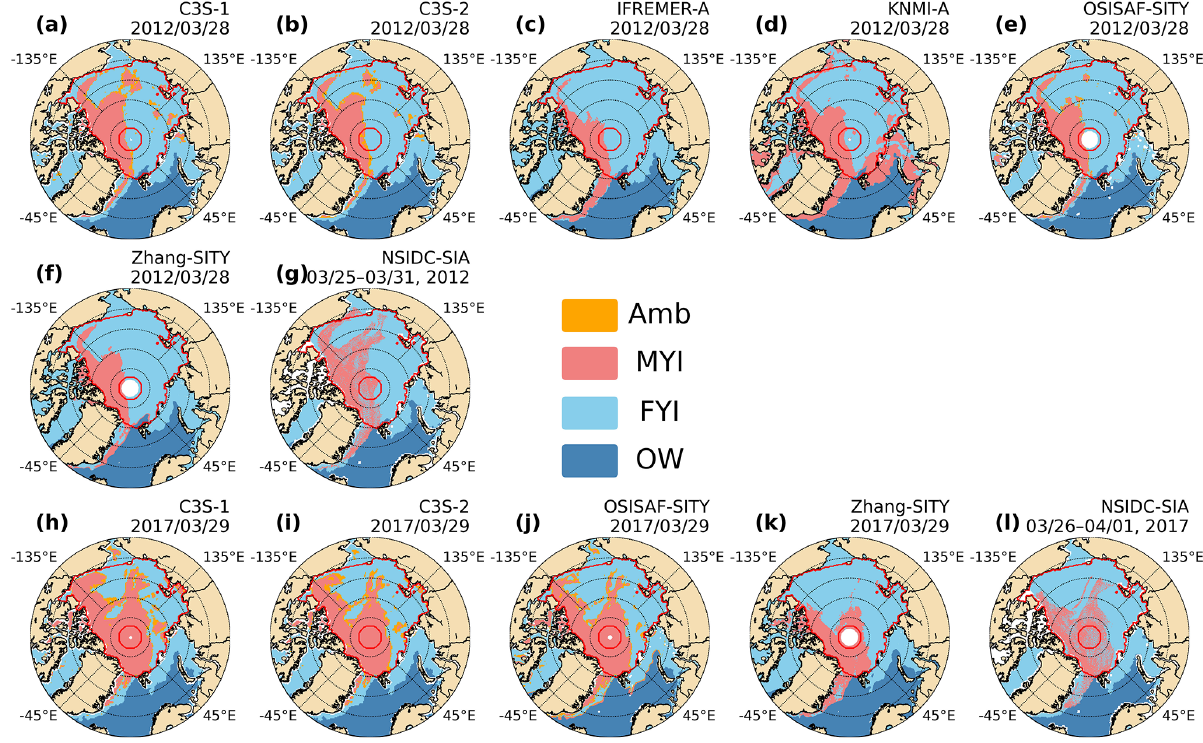
Figure 8. Arctic SITY distribution maps from daily SITY products and weekly NSIDC-SIA on 28 March 2012 (a–g) and 29 March 2017 (i– l)